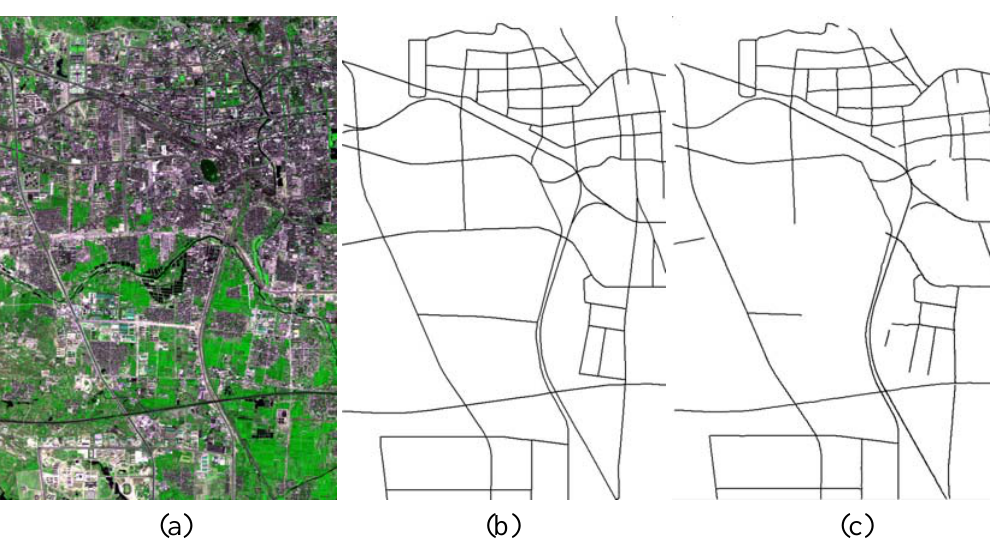
Figure 5. Road network extraction from a QuickBird satellite image. (a) QuickBird fused image with 0.61 m pixel -1 resolution and the image size is 15,368 pixels by 10,240 pixels; (b) the reference road network plotted; (c) the extracted vector road network by the combination